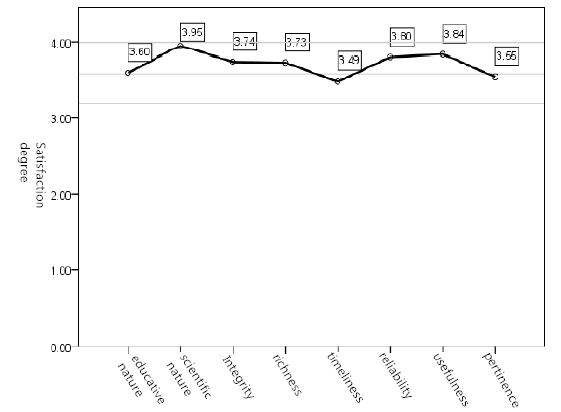
Figure 4: Content quality learner